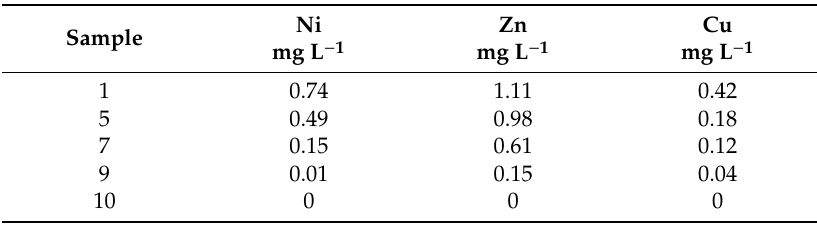
Table 8. Results of the individual parameters monitored during the regeneration of spent biosorbent—a mixture of cones of coniferous